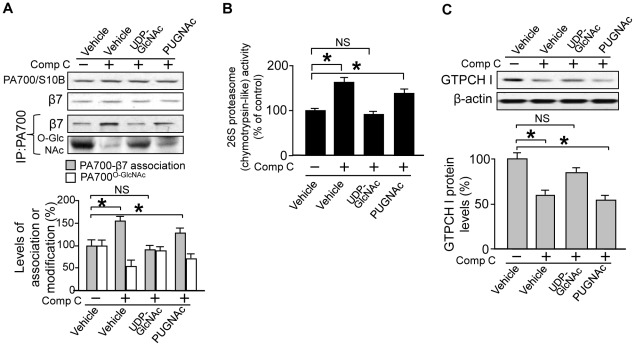
Activation of OGT prevents AMPK-inhibition induced 26S proteasome activation.AMPK suppression by compound C (10 µmol/L for 2 hour) in HUVEC (A) increases the association of PA700/S10B (from 19S complex) with β7 (from 20S complex) accompanied by a decrease of PA700/S10B O-GlcNAc modification, and (B) increases 26S proteasome activity, which can be prevented by pre-incubation of UDP-GlcNAc (25 µmol/L for 30 min), but not by PUGNAc (14 µmol/L for 30 min), the inhibitor of O-GlcNAcase. The blots shown are representative of 3 independent experiments.